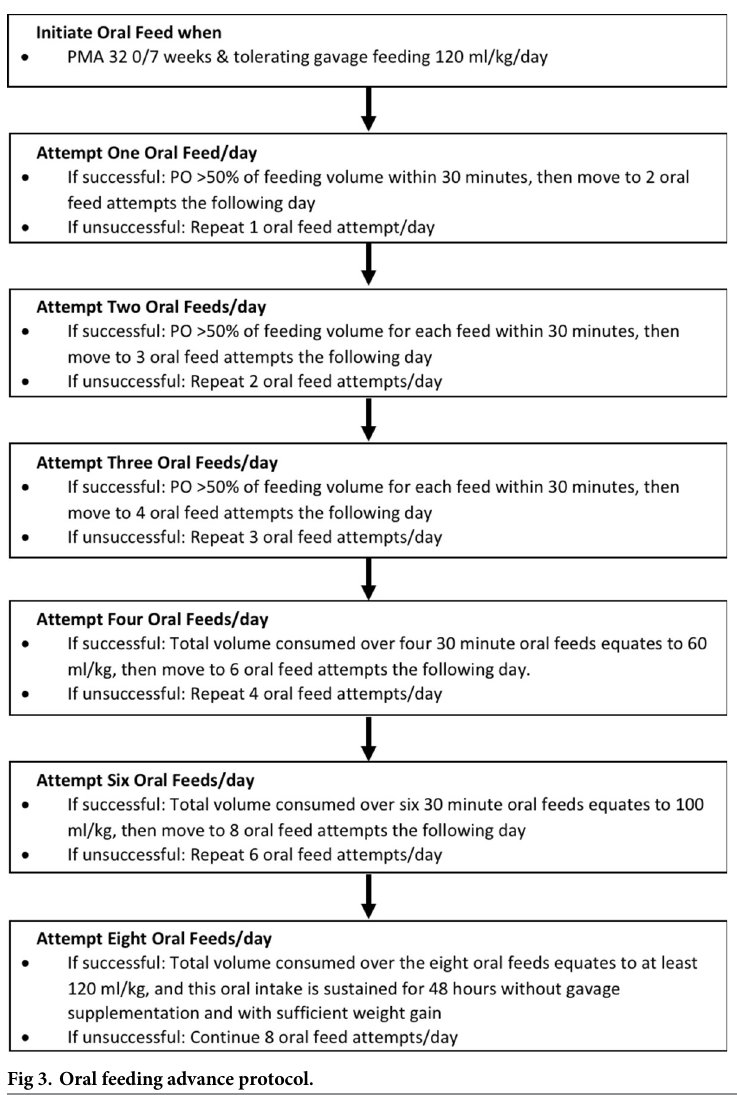
Fig 3. Oral feeding advance